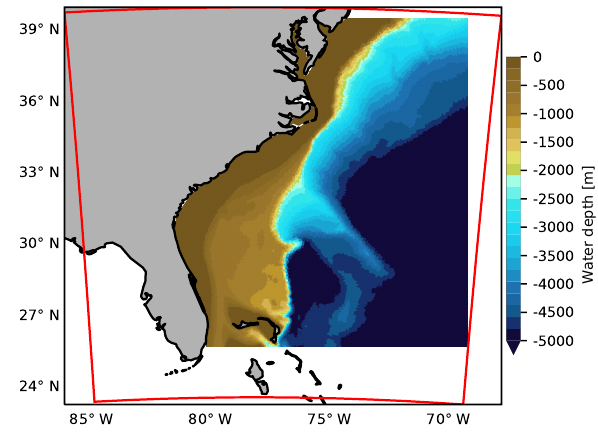
Figure 4. Horizontal extent and bathymetry of the wave model do- main in MIKE 21 SW together with the extent of the inner domain used in the atmospheric model